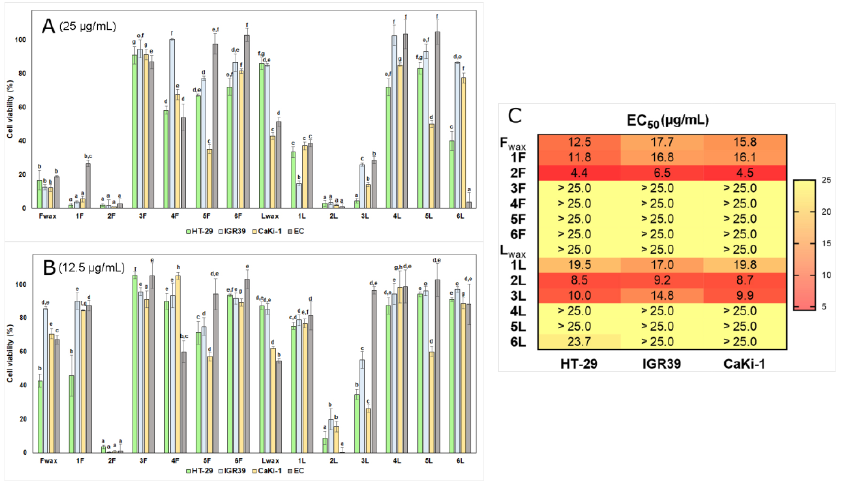
Figure 4. Cytotoxicity of cuticular waxes (L wax , F wax ) and fractions (1–6L and 1–6F) of lingonberry leaves and fruits in 2D cell cultures (cell monolayers). ( A ) Cell viability in HT-29, IGR39, CaKi-1, and EC lines at a concentration of 25 µ g/mL. ( B ) Cell viability in HT-29, IGR39, CaKi-1, and EC lines at a concentration of 12.5 µ g/mL. ( C ) EC 50 values against cancer cell lines. Bars marked with different letters indicate statistically significant differences ( p < 0.05) within the same